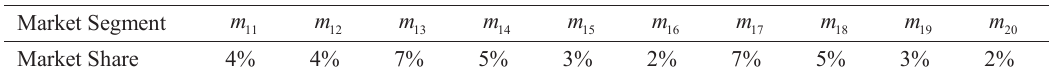
Table 5. Segments and their market shares